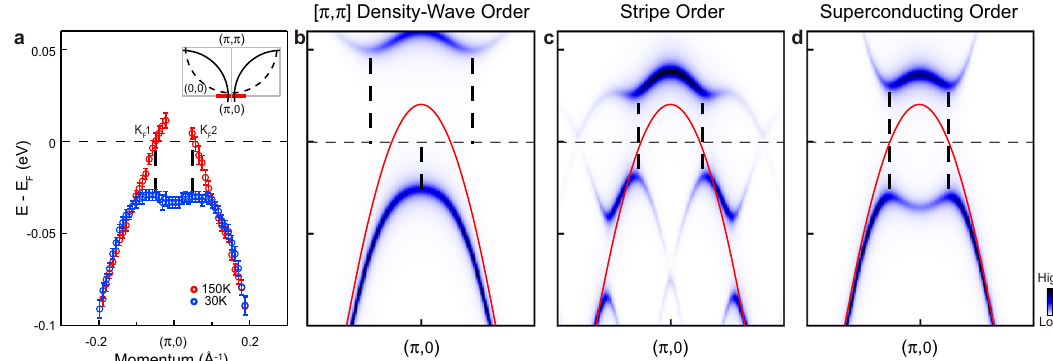
Fig. 3 Comparison of different electronic orders. a Experimental dispersion in the normal and gapped states. b – d , Simulated spectra for commensurate [ π , π ] density-wave order ( b ), stripe order with a wave vector connecting K F 1 and K F 2 ( c ) and superconducting order ( d ). Red curves represent the bare band in the simulation. Black dashed lines mark the back-bending momenta in the gapped states.